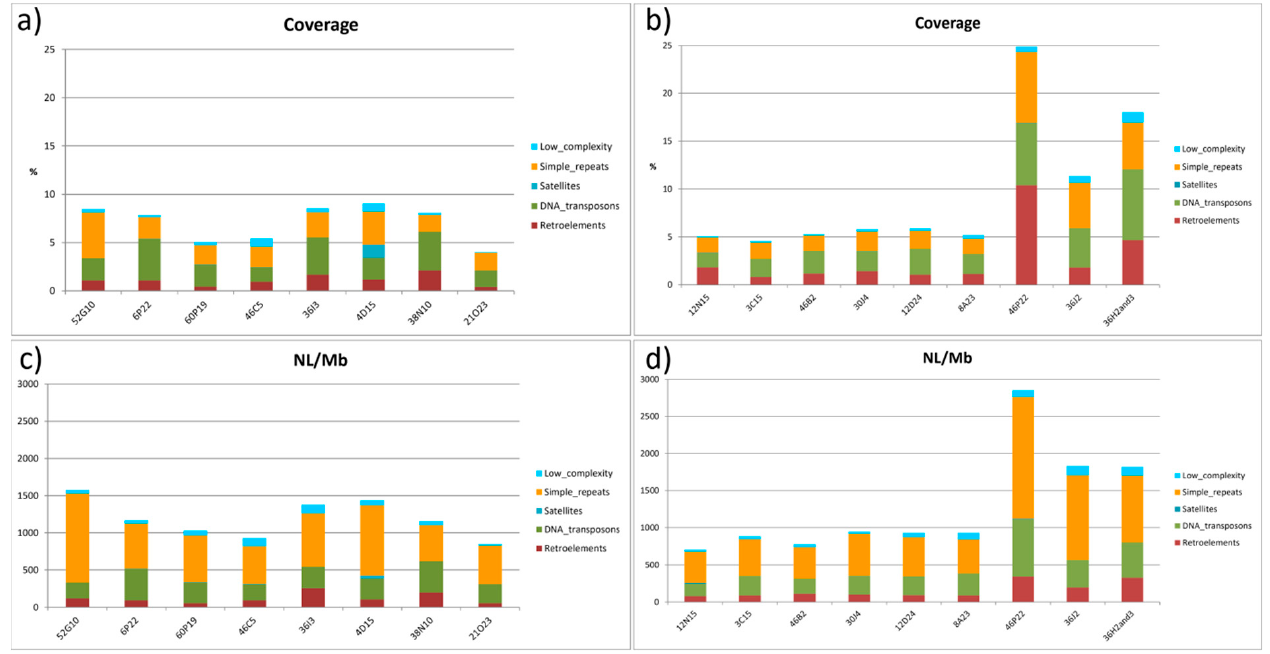
Figure 6. Summary of repeat types present in the BACs located in chromosomes 2 ( a ), ( c ), and 4 ( b ), ( d ) of Solea senegalensis . Coverage is measured as the percentage of repeat elements per BAC length. NL/Mb is the number of loci per Mb of BAC sequenced.